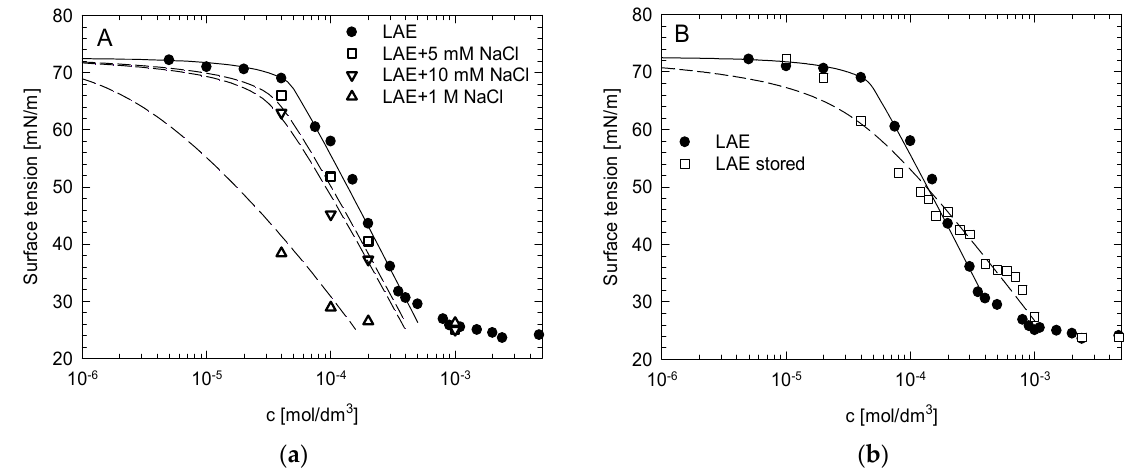
Figure 2. ( a ) The change of the dependence of surface tension on the concentration of LAE solution upon addition of salt (NaCl); ( b ) the comparison of LAE surface tension isotherms for freshly prepared and “stored” solution. Lines represent fits to the model of LAE adsorption accounting for the formation of LAE-dodecanoate or LAE-LAS heterodimers.